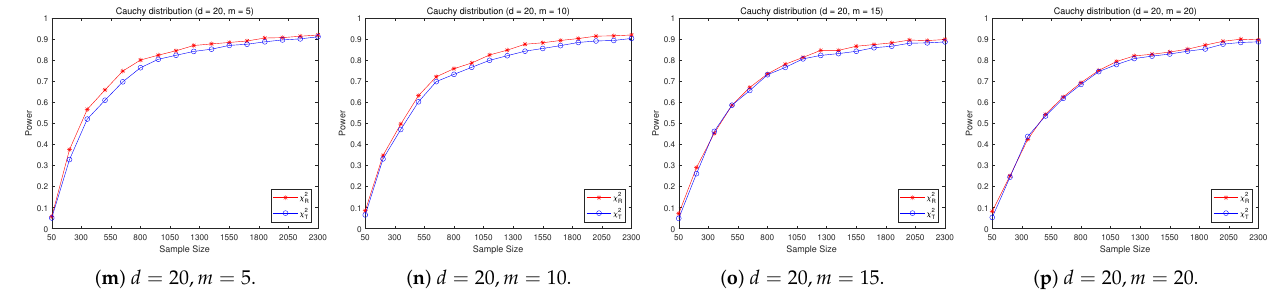
Figure 1. The Cauchy distribution. Red line for RP-chi-square, blue line for traditional chi-square.